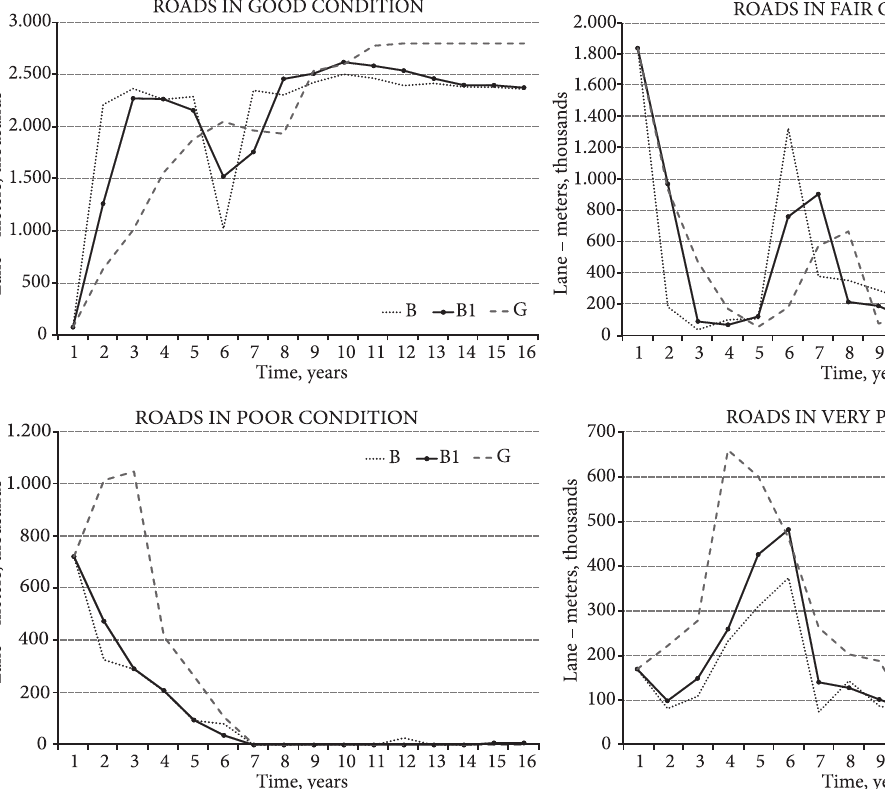
fig. 4. Qualitative progression of road condition